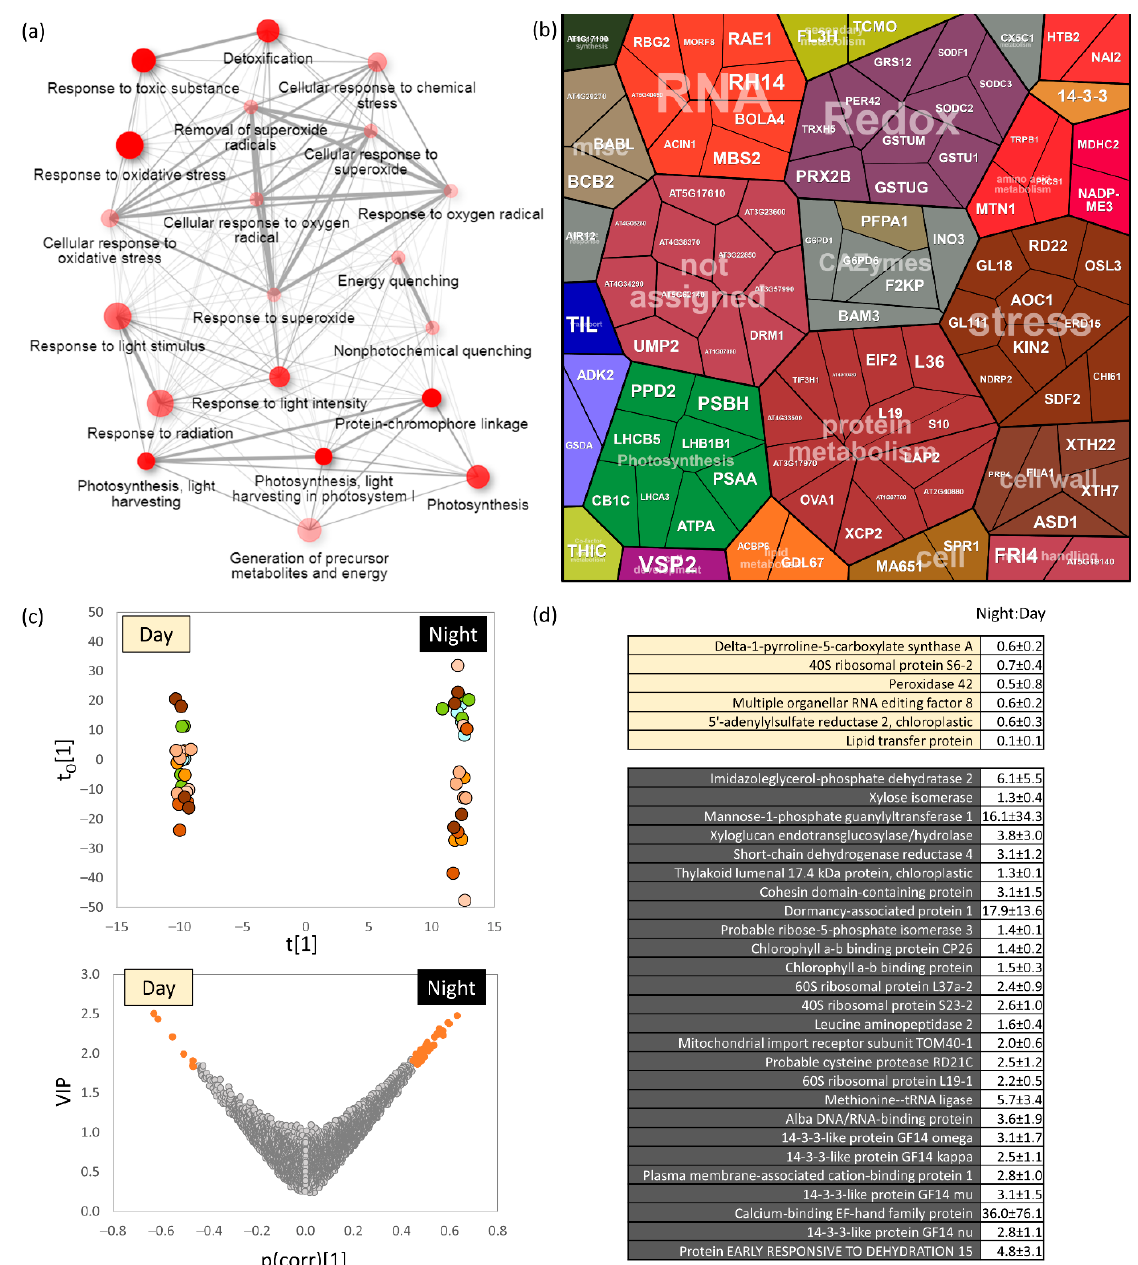
Figure 4. Diurnal variation in Col-0. ( a ) The most significant categories of gene ontology (GO) found in diurnally regulated proteins; ( b ) Visualization of all differentially abundant proteins ( p < 0.05, at least a 1.5-fold change) in ProteoMap; ( c ) Identification of diurnal variations that were preserved in most mutants. The orthogonal partial least squares discriminant analysis and VIP (variable importance in projection) and ( d ) identified proteins (absolute threshold 0.5) are listed. The night–day ratio represents the mean ratio and standard deviation andcolor-coding in in the OPLS plot corresponds to Figure 3c. For details, see Supplementary Table S1.